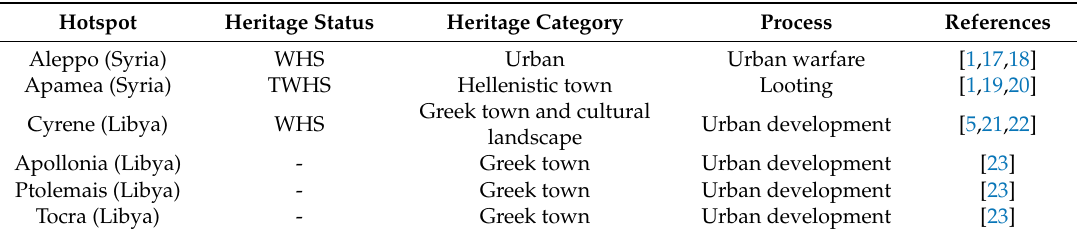
Table 1. The summary of the demonstration sites with an indication of the heritage status (if applicable); the heritage category; the type of process impacting the site conservation that is discussed in this paper; references for a historical, archaeological, and conservation introduction to the sites. Notation: WHS = World Heritage Site; TWHS = Tentative